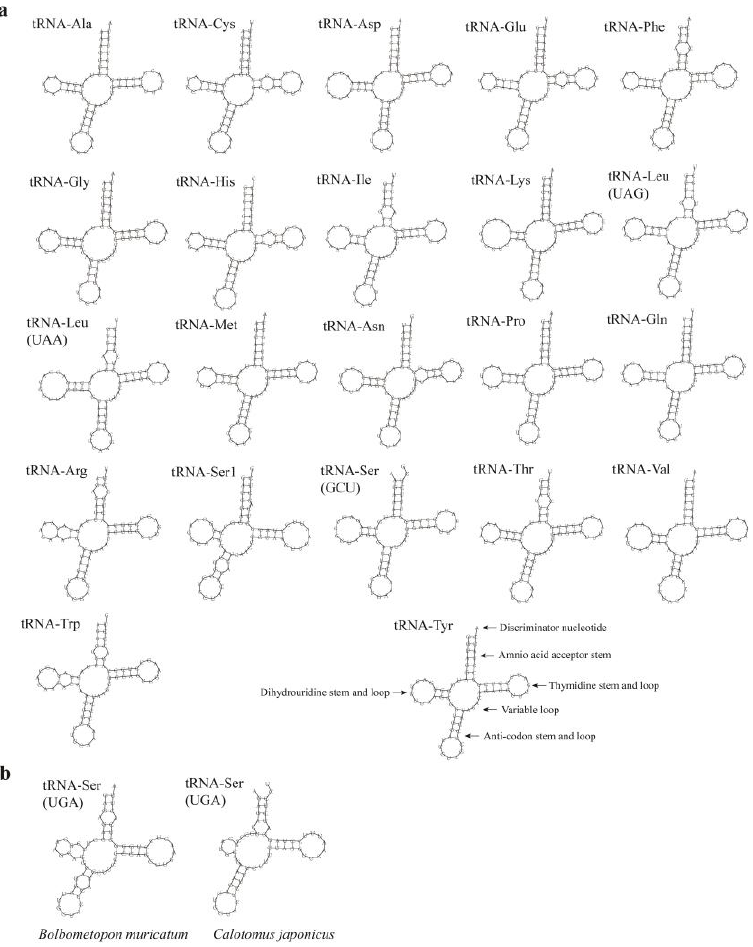
Figure 4. ( a ) Putative secondary structure of tRNAs in parrotfish mitogenomes. ( b ) Putative secondary structure of tRNA Ser (AGN) in Bolbometopon muricatum and Calotomus japonicus .